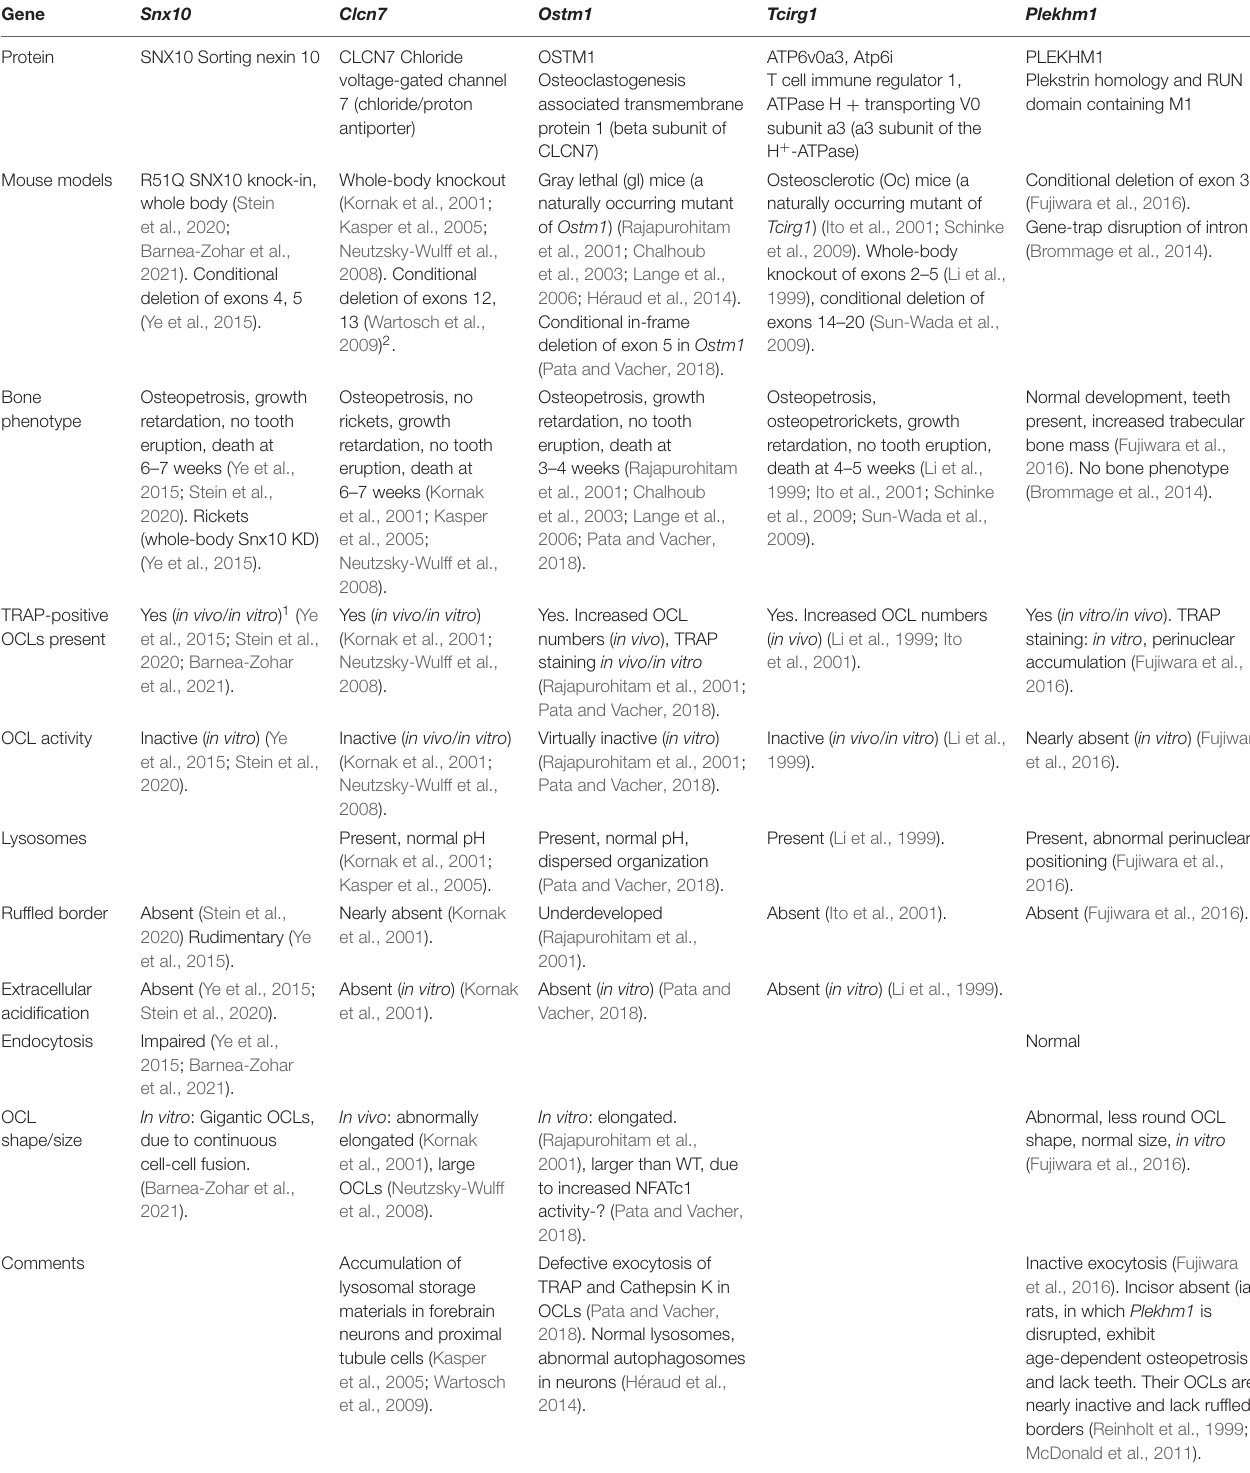
TABLE 2 | Key cellular phenotypes in OCLs from “OCL-rich” ARO mouse